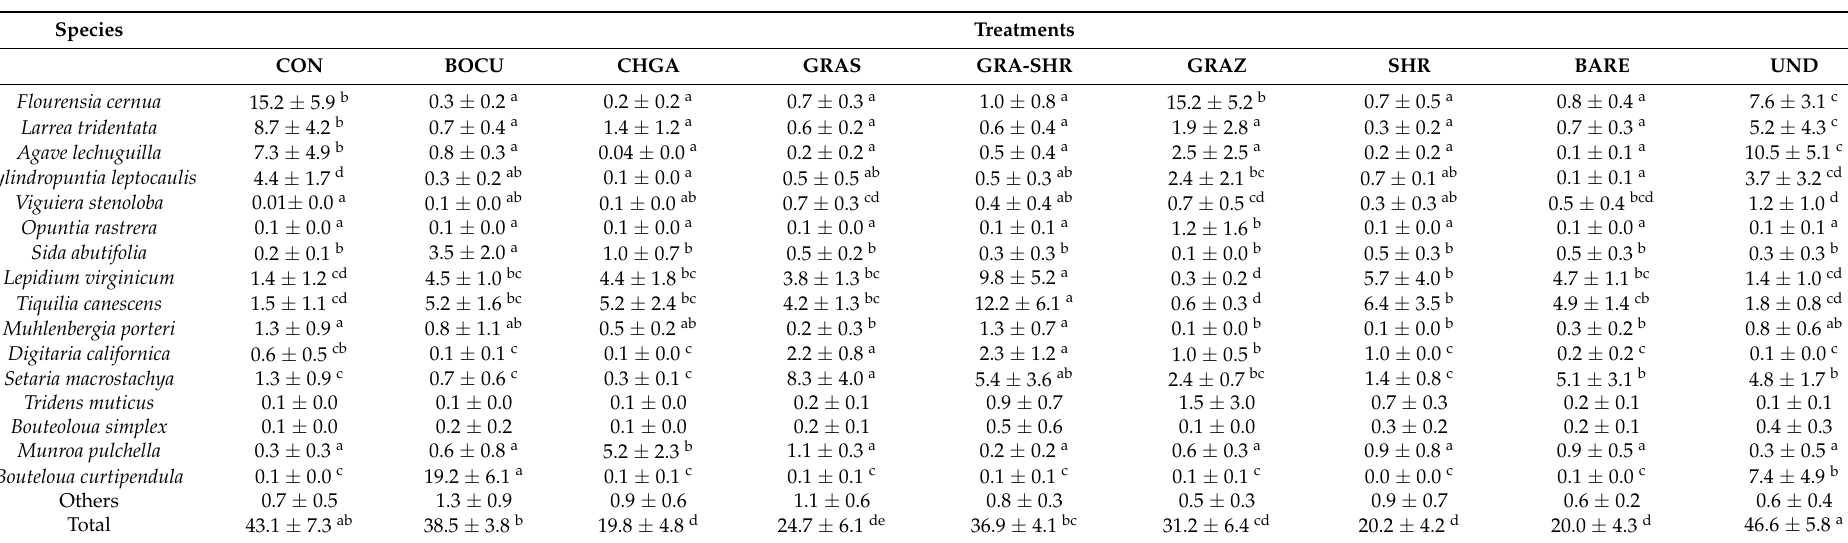
Table 1. Plant canopy cover (%) * by main species in sites of a microphyllous desert shrubland subjected to different transformations including seeding of perennial native or introduced grasses. Estimations of canopy cover were registered four years after treatments were imposed. Values are means ± standard deviation.